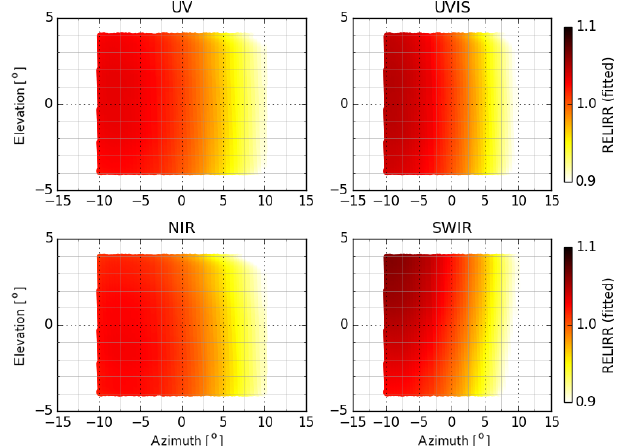
Figure 9. The fit for the values in Fig. 8 using an eighth-order Chebyshev polynomial both in the azimuth and elevation direction. The polynomial was fitted to values between − 10 and + 10 ◦ in the azimuth direction and − 4 and + 4 ◦ in the elevation direction.